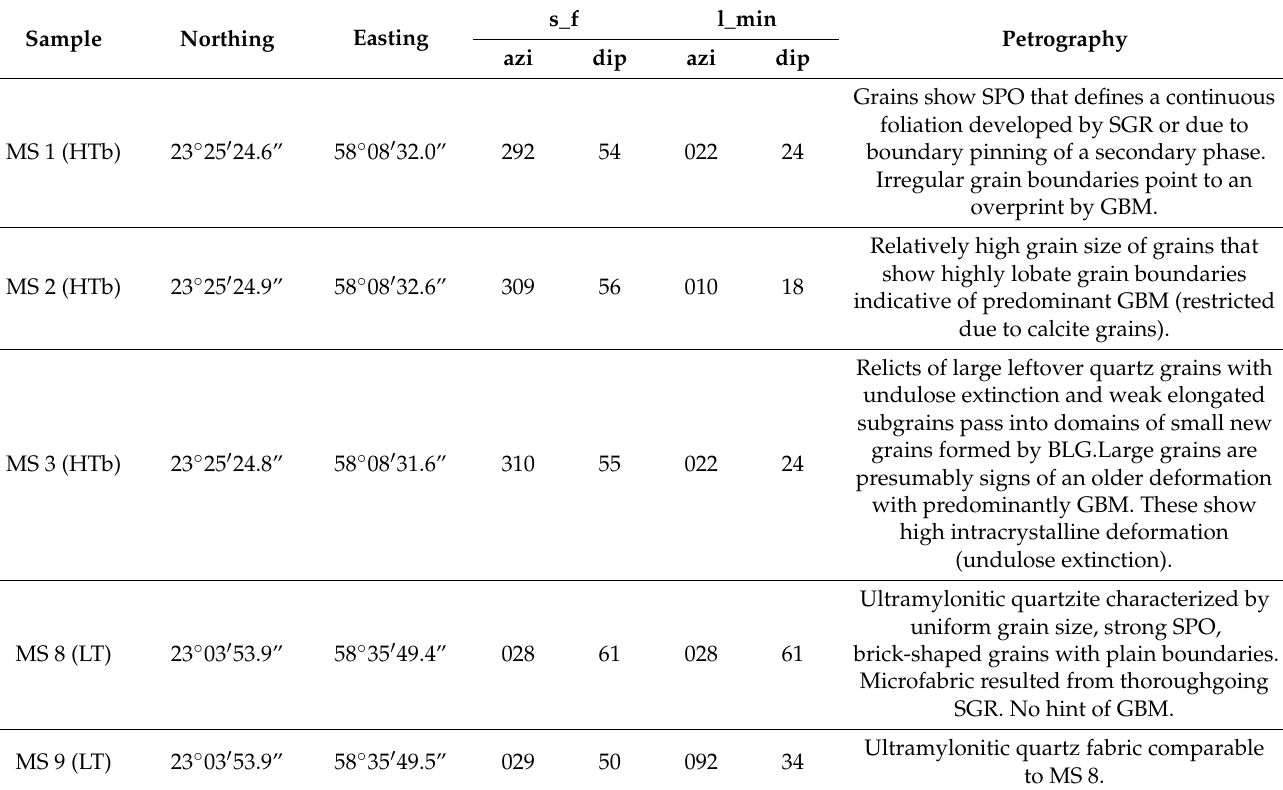
Table 1. Sample descriptions of the